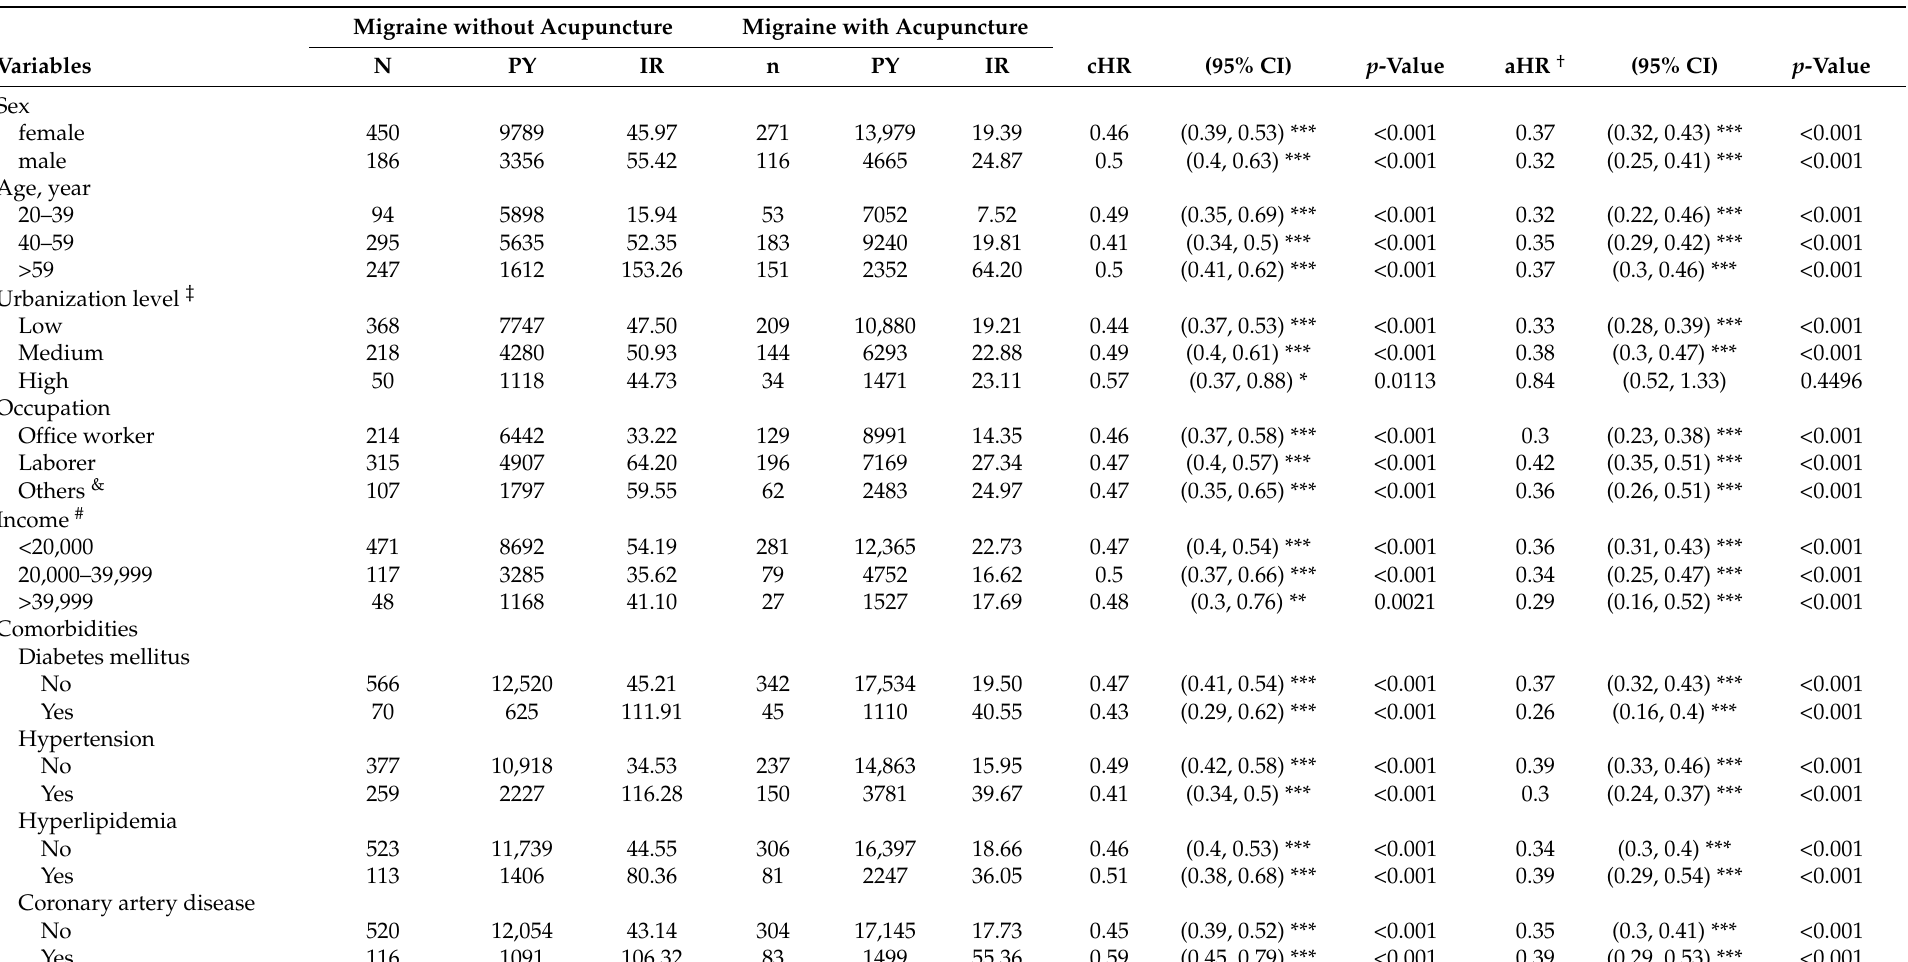
Table 3. Incidence rates, hazard ratios (HRs), and 95% confidence intervals (CIs) of strokes for migraine patients who did and did not receive acupuncture treatment in different